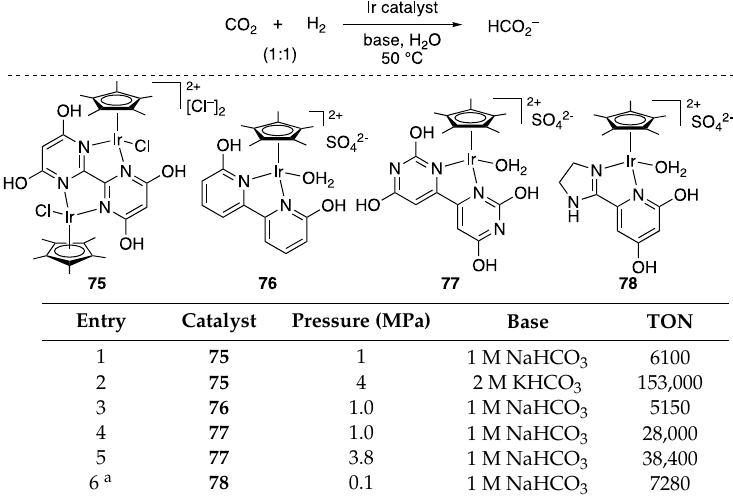
Table 1. Hydrogenation of CO 2 to formate salt under aqueous conditions catalyzed by Ir complexes 75–78 bearing hydroxypyridine- or hydroxypyrimidine-based ligands.